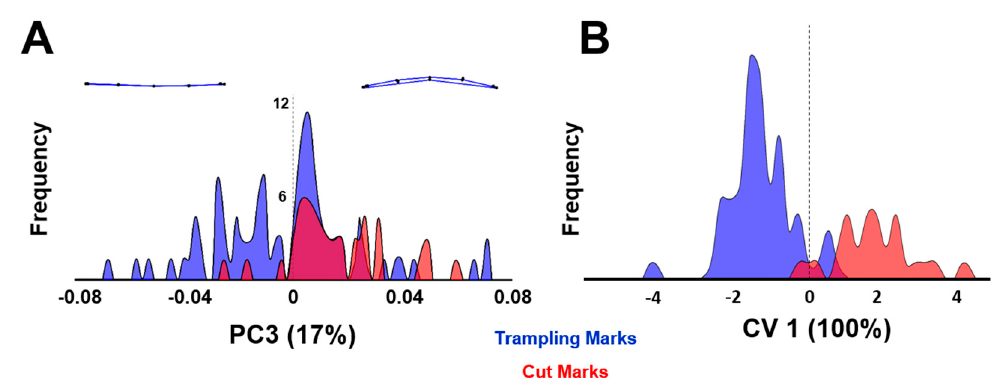
Figure 4. Principal components and Canonical Variance Analysis comparing Cut and Trampling Mark morphologies. ( A ) Distribution of samples across Principal Component 3 with extreme shape changes graphically presented at the extremity of each side of the axis. ( B ) Distribution of samples in Canonical Variance Analyses.